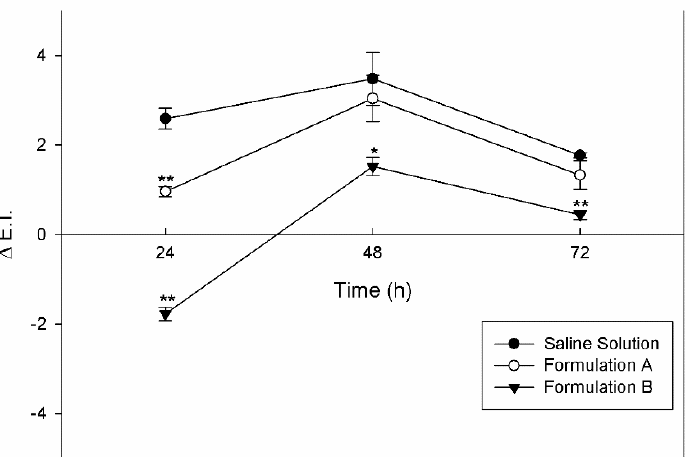
Figure 4. In vivo skin tolerability analysis carried out on human volunteers. Saline solution, Formulation A, and Formulation B were applied on forearms and the Δ E.I. was detected as a function of exposure time (24, 48 and 72h). Results are expressed as mean value of three different experiments from three different batches ± standard deviation. If bars are not visible, they are within the symbol. * p < 0.05 and ** p < 0.001 versus saline solution tested at the same time of treatments.